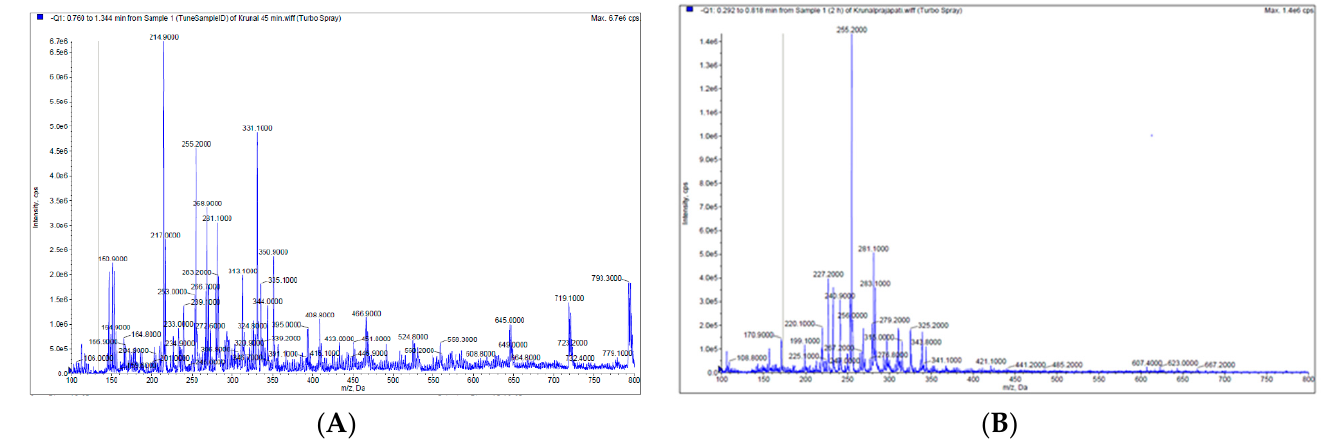
Figure 4. ( A ): MS of TurmiZn complex in rat plasma sample (45 min) of 5 g/Kg oral dose). ( B ): MS of TurmiZn in rat plasma sample (2 h) of 5 g/Kg oral dose).